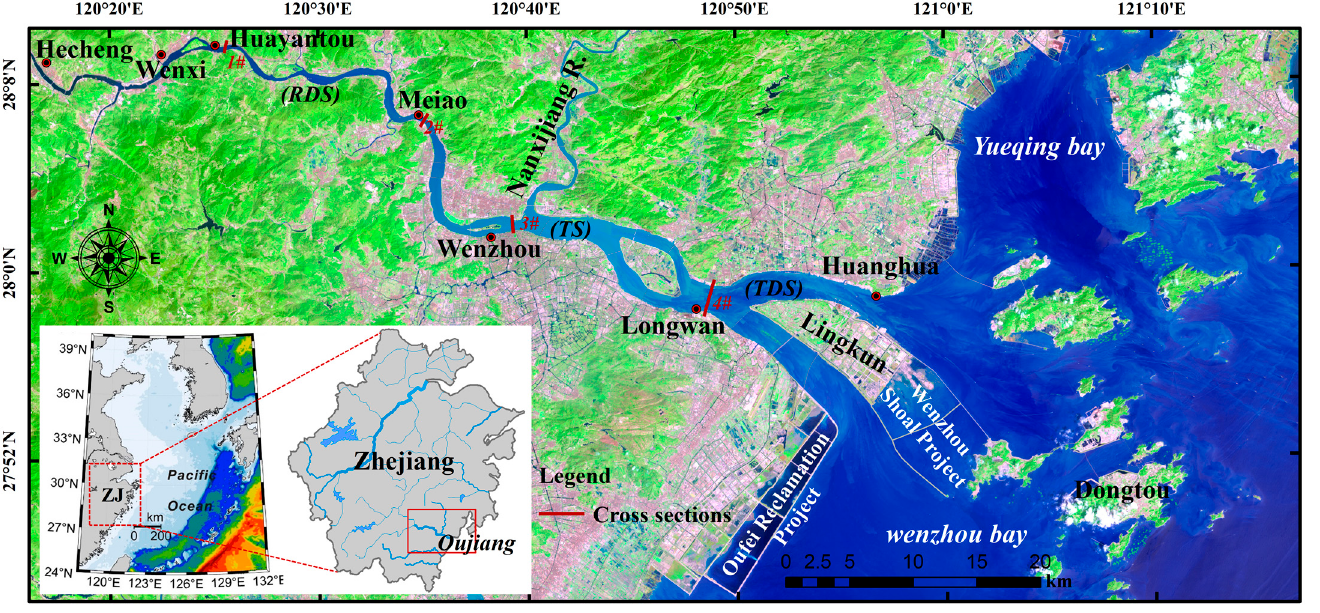
Figure 1. Remote sensing image of the study area in April 2020 based on Landsat8-OLI.